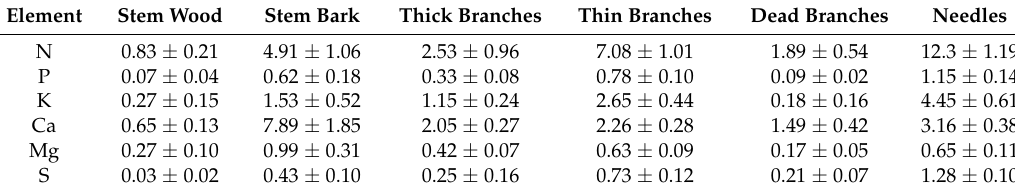
Table 3. Mean ( ± SD) concentration (mg · g − 1 ) of elements for all (N = 15) sampled Scots pine model trees.